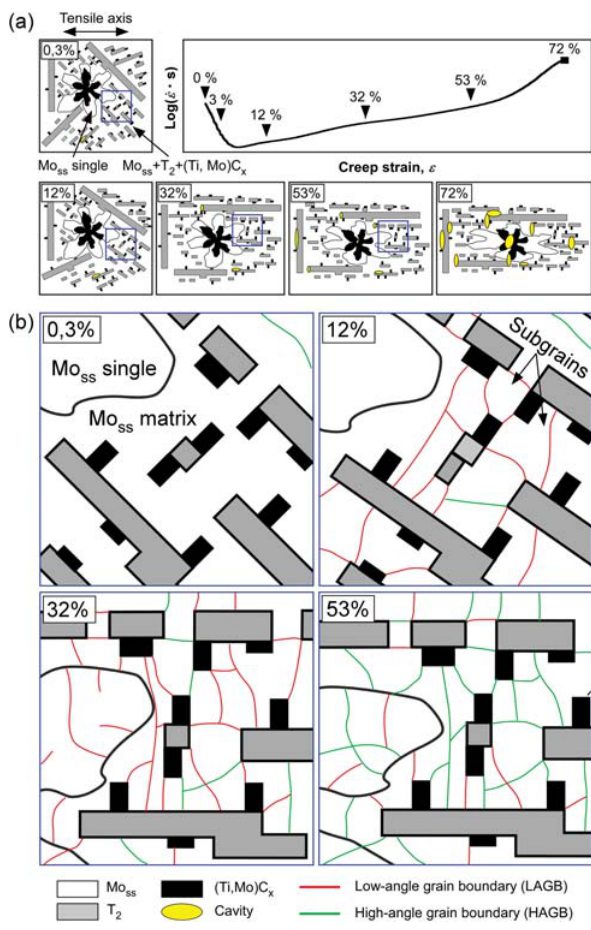
Figure 12: Schematic illustration of microstructural evolution during creep deformation of the MoSiBTiC alloy at 1,500°C and 137 MPa. ( a ) Creep curve and microstructural change of each constituent phase in each strain and ( b ) the enlargement of the area enclosed by a square shown in ( a )